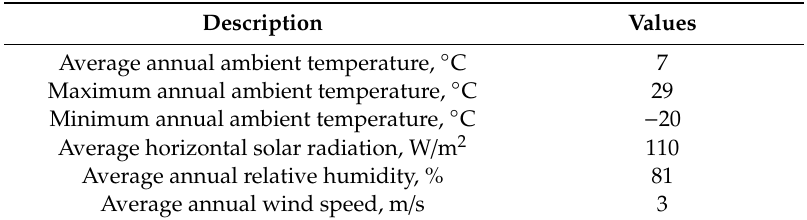
Figure 5. Climatic key parameters for Växjö based on the meteorological data for 2013 obtained from Meteonorm software. Table 8. Key climate data for Växjö as location used for the energy balance analysis.